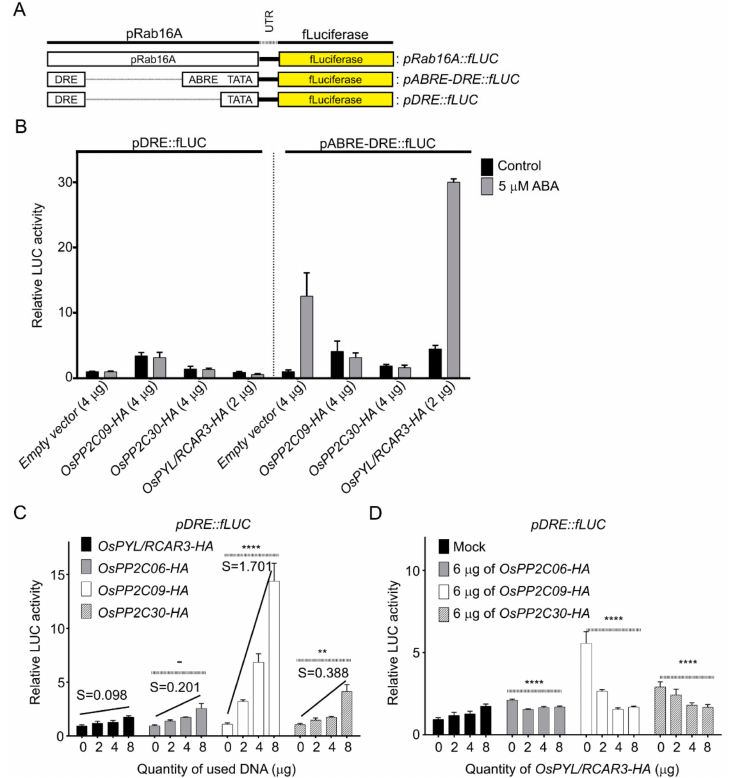
Figure 3. OsPP2Cs activate Rab16a transcription via cis -DRE. ( A ), Schematics of generated re- porter plasmids, pABRE-DRE::fLUC and pDRE::fLUC . ( B ), Activation test of pABRE-DRE::fLUC or pDRE::fLUC with effector only or ABA in rice protoplasts. ( C ), Activation of the pDRE::fLUC reporter with increasing amounts of the indicated effector DNA during transfection. ( D ), Effects of OsPYL/RCAR3 overexpression on OsPP2C-mediated induction of luciferase activity from the pDRE::fLUC reporter. The indicated effector and marker DNAs were introduced into rice proto- plasts by PEG-mediated transfection and then incubated for 15 h. Induced luciferase activity was detected with a dual-luciferase reporter assay system. All values are means ± SD ( n = 3). S is the slope of the trend line. Two-way ANOVAs (main column effect) were performed, comparing to OsPYL/RCAR3-HA values (****: p < 0.0001, **: p < 0.01, -: not